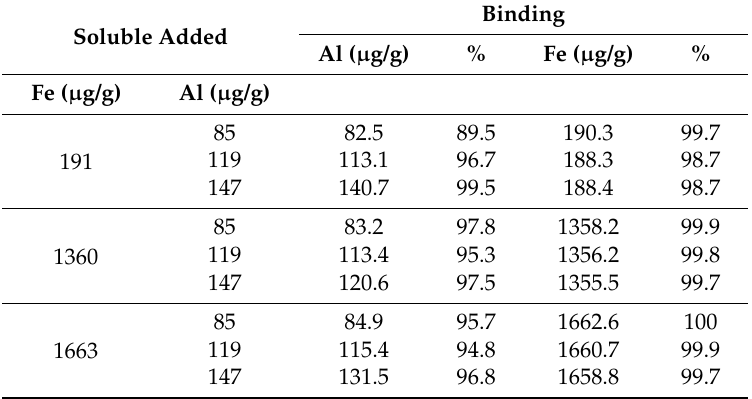
Table 6. Al and Fe binding to biochar at pH 7 in mixtures of different metal